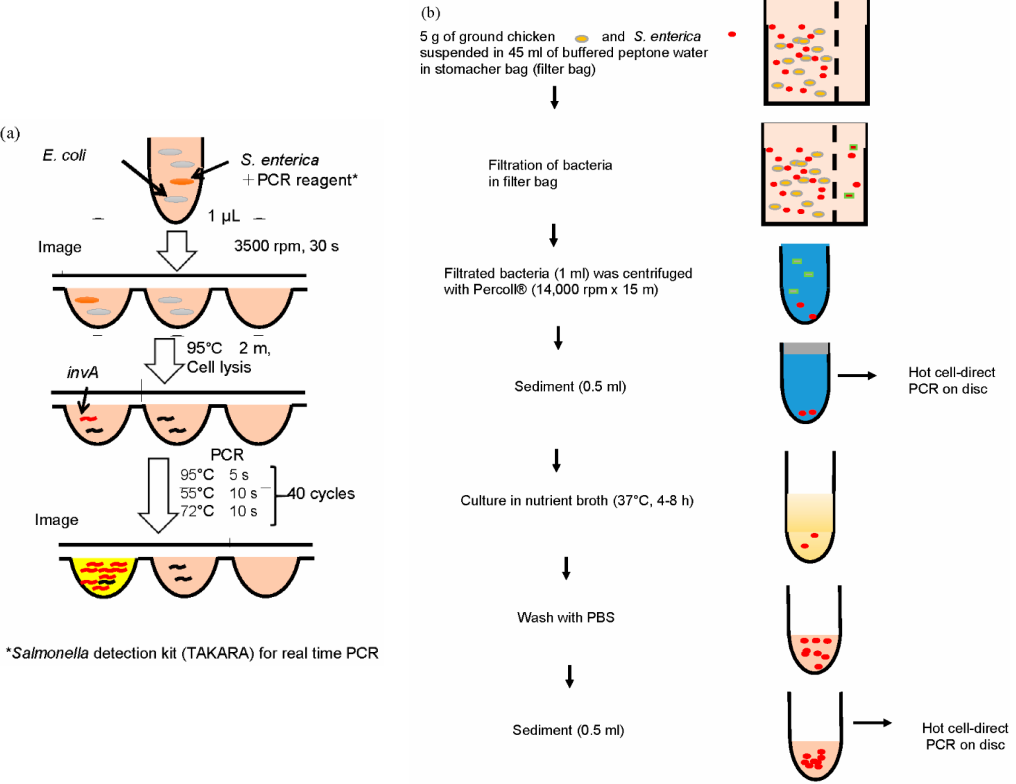
Figure 2. Detection scheme. ( a ) detection of S. enterica using the CD-shaped device by the detection system; ( b ) pre-treatment of chicken meat spiked with S. enterica .